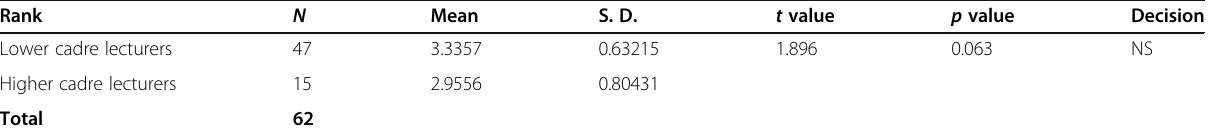
Table 5 Independent sample t test of the two categories of lecturers on perceived quality of radiographers that will be produced by the program Rank N Mean S. D.